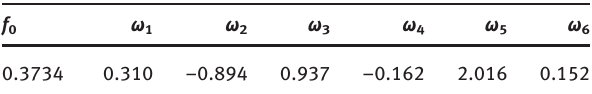
Table 3: The values of converged weights obtained by multivariate linear